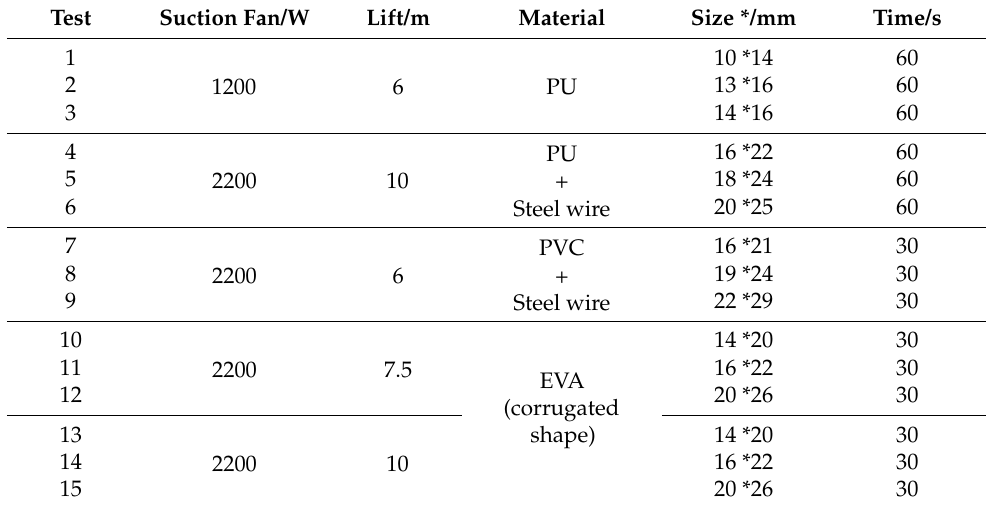
Table 2. Removal efficiency tests for absorber ball removal in a gas environment.